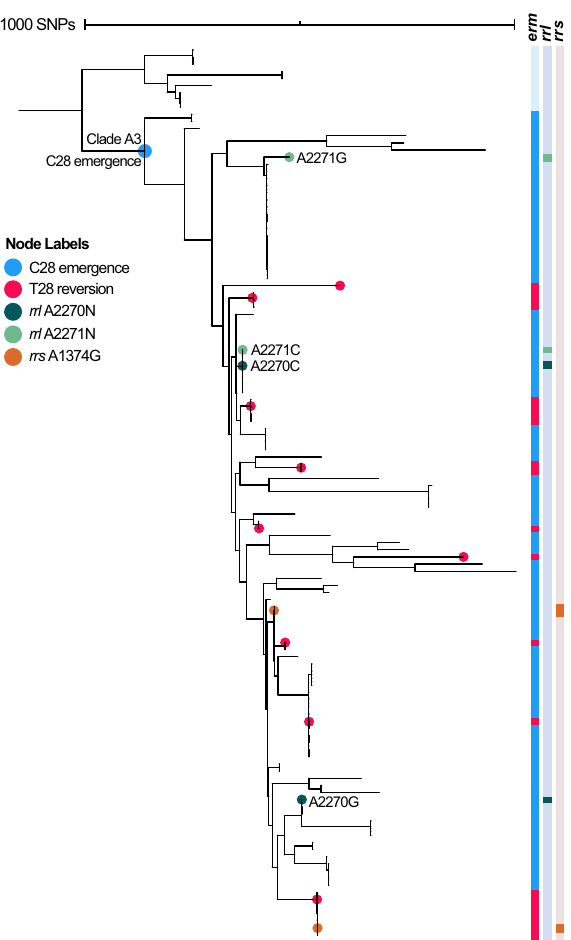
Fig. 4 Molecular evolution of macrolide and amikacin susceptibility within M. abscessus clone A3. Midpoint rooted maximum-likelihood phylogeny of 116 members of clone A3. Each evolutionary gain or loss of a drug resistance mutation was assigned to its position on the phylogeny using parsimony. Given its basilar position on the phylogeny, the T28C erm (41) variant (blue circle), which precludes inducible macrolide resistance, occurred earlier in time, with subsequent-independent reversions back to T28 (red circles), indicating a regain of the inducible macrolide resistance phenotype. Within the clade, additional acquisitions of constitutive macrolide and amikacin resistance were also observed, with emergence of rrl A2270C ( E. coli A2058C), rrl A2270G ( E. coli A2058G), rrl A2271C ( E. coli A2059C), rrl A2271G ( E. coli A2059G), and rrs A1374G ( E. coli A1408G). Bootstrap values ( ≥ 80%) support the independent, convergent acquisition of each instance of macrolide and amikacin